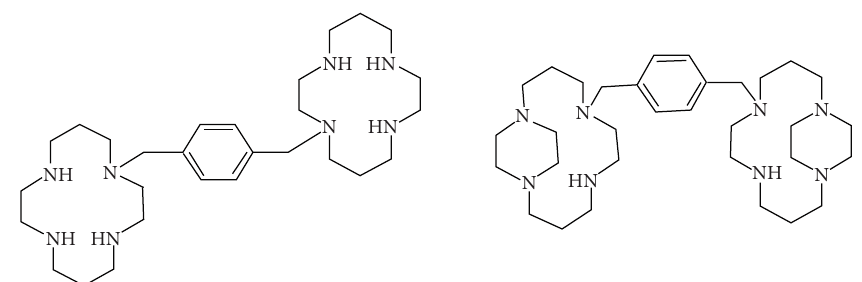
Figure 6: Antiviral macrocyclic bicyclams AMD3100 (9); constrained analogue of AMD3100